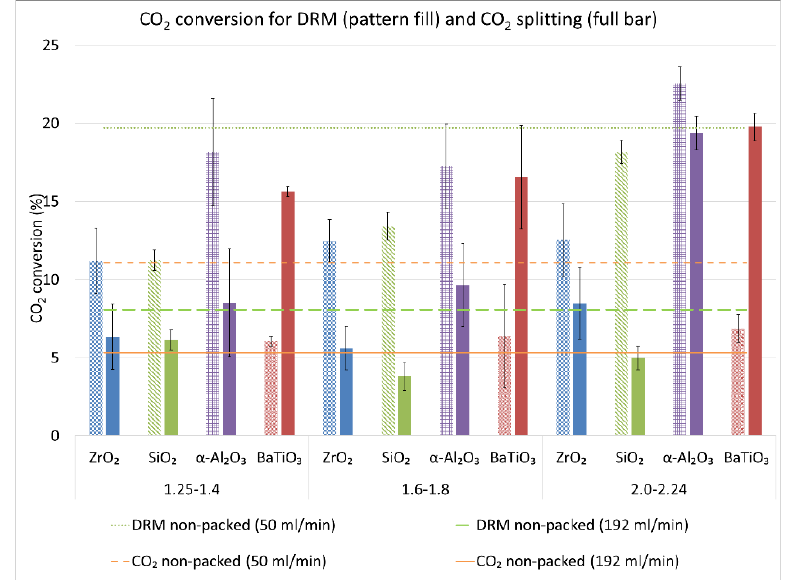
Figure 1. CO 2 conversion for different sphere sizes and materials, compared to the results for the non-packed reactor, at the same flow rate (50 mL/min) and at the same residence time (5.52 s; flow rate of 192 mL/min), all at 23 kHz frequency, in a 4.5 mm gap and a set 100 Watt power for both DRM (dry reforming of methane) and pure CO 2 splitting. The bars with pattern fill show the results for DRM, whereas the full bars show the correct results for CO 2 splitting, obtained from our previous work [2].